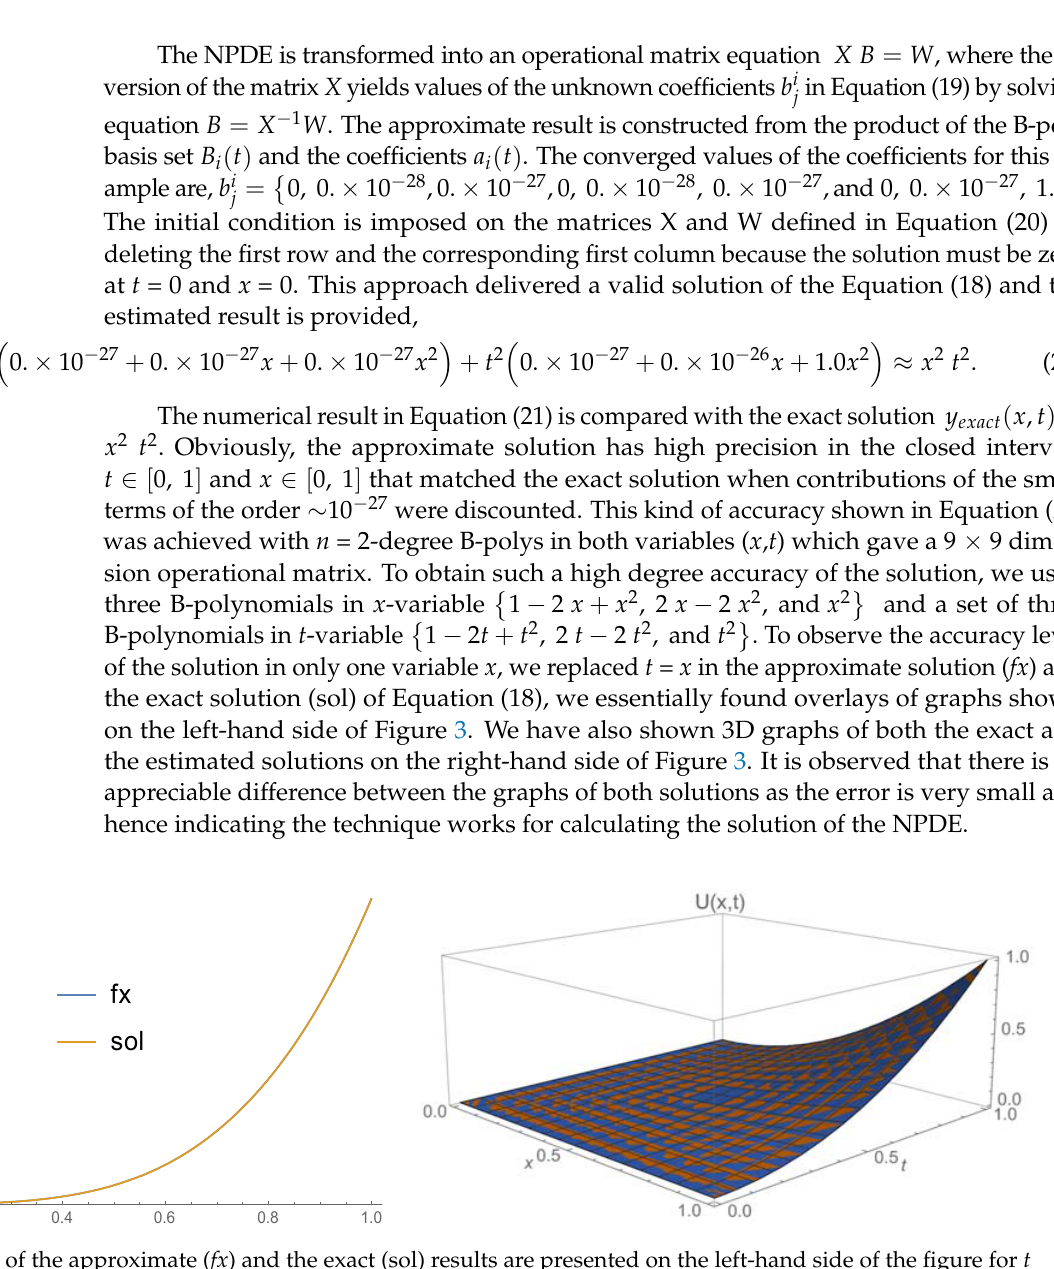
Figure 3. Graphs of the approximate ( fx ) and the exact (sol) results are presented on the left-hand side of the figure for t = x and both solutions essentially overlap each other in one dimension. On the right-hand side, a 3D plot of exact and approximate solutions is provided over the intervals t ∈ [0,1] and x ∈ [0,1], which shows the accuracy of the numerical results because both graphs overlapped, showing no appreciable difference between them.